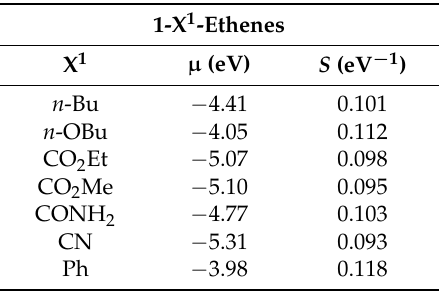
Table 4. Calculated chemical potential µ and global softness S of the investigated 1-X 1 -ethenes. 1-X 1 -Ethenes